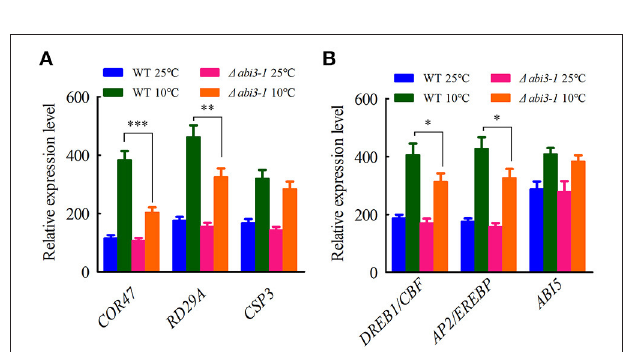
FIGURE 3 | PpABI3 is involved in regulating enzymatic antioxidative signaling. (A–D) Antioxidant enzymatic activities analysis. Protonema after incubation under standard growth temperature (25 ◦ C) or low temperature (10 ◦ C) for 2 weeks were harvested to analyze ascorbate peroxidase (APX) activities (A) , catalase (CAT) activities (B) , glutathione peroxidase (POD) activities (C) and superoxide dismutase (SOD) (D) . Error bars represent SD ( n = 3) and two-way ANOVA was used to determine the statistical significance (** P < 0.01). Experimental details are found in Materials and Methods.